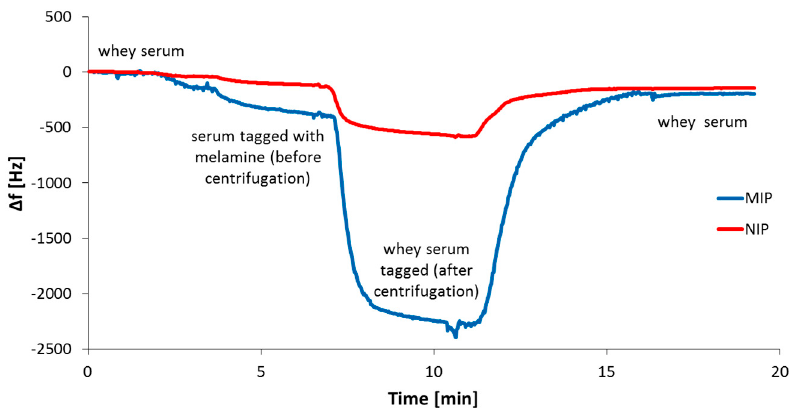
Figure 6. Centrifugation as a means of sample preparation: Sensor effects of serum aliquots tagged with melamine before and after centrifugation.